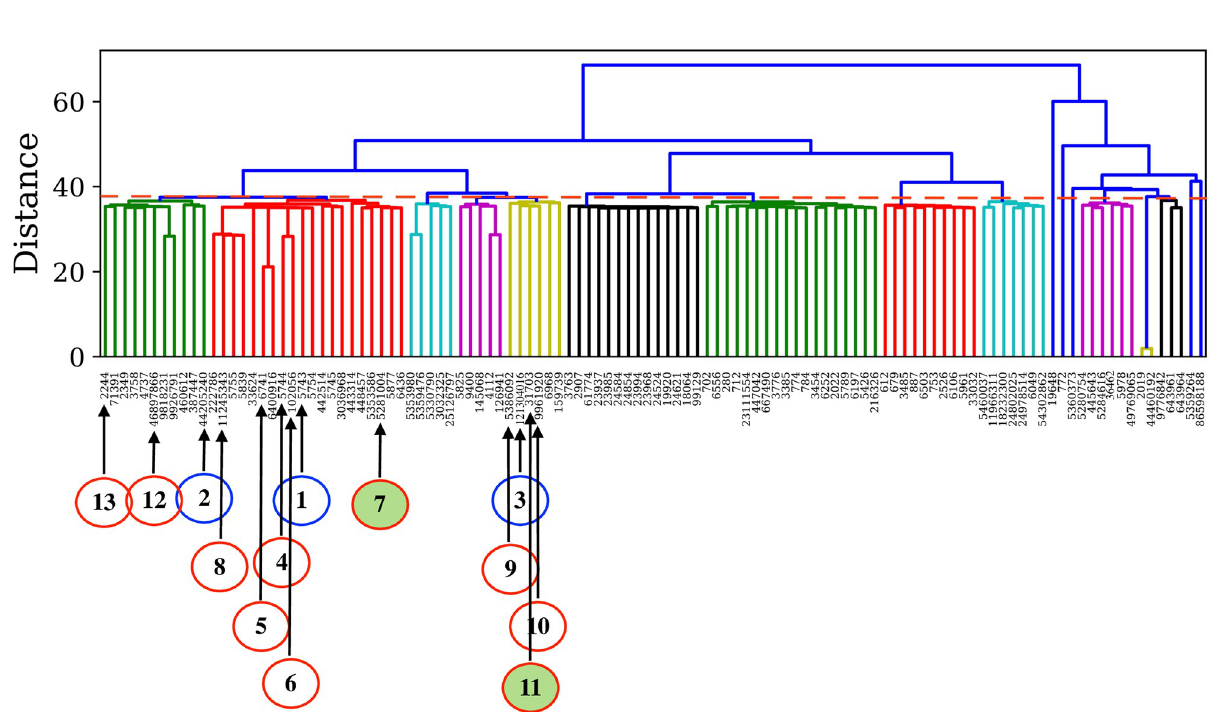
Fig 5. Dendrogram obtained from HAC showing three different clusters associated with the reference drugs. The distance (represented by a dashed red line) is chosen at 38 for the cluster formation. The reference drugs and the top 10 similar drugs quoted in Table 1 are indicated using blue and red circles, respectively, with connected arrows. The best two drug candidates are highlighted via filled red circles.